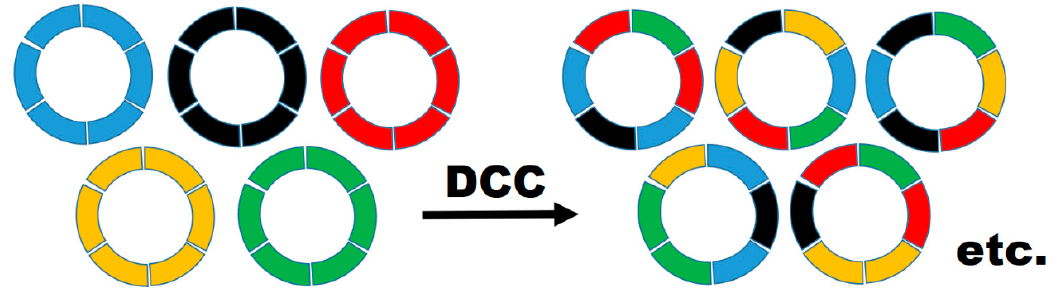
Figure 1. An image of advanced multitopic DCC systems. Recombination of five kinds of self-assembled cyclic hexamers gives various heterogeneous cyclic hexamers.